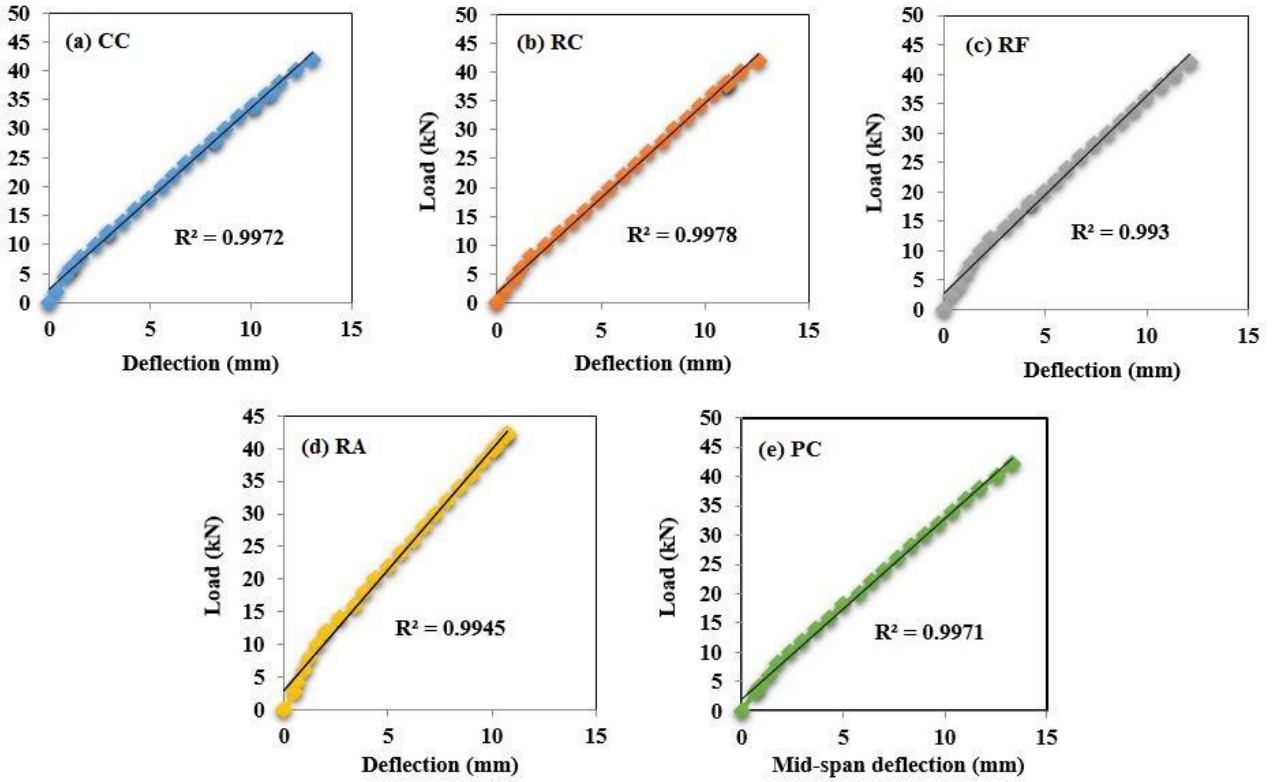
Figure 5. Load-dependent mid-span deflection of the studied beams in the linear region showing the data correlation ( a ) CC ( b ) RC ( c ) RF ( d ) RA ( e ) PC. data correlation ( a ) CC ( b ) RC ( c ) RF ( d ) RA ( e )